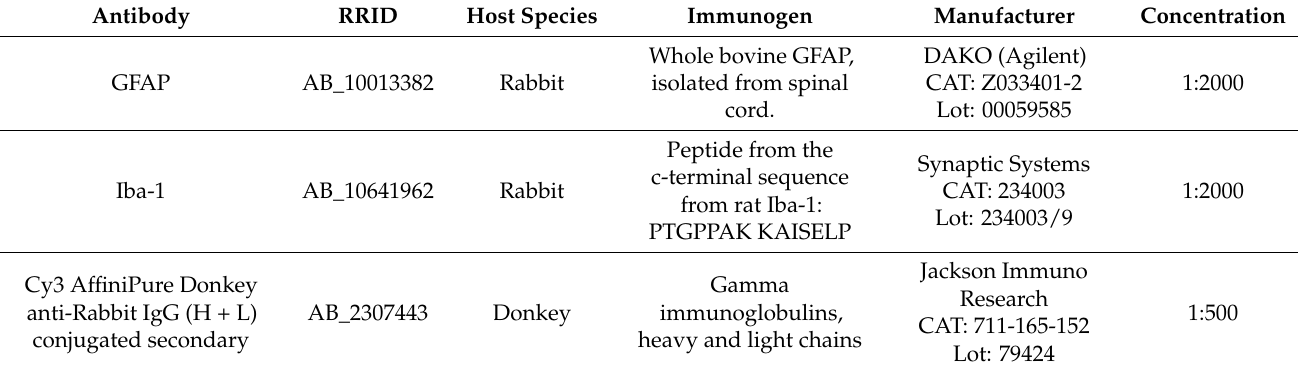
Table 1. Antibody